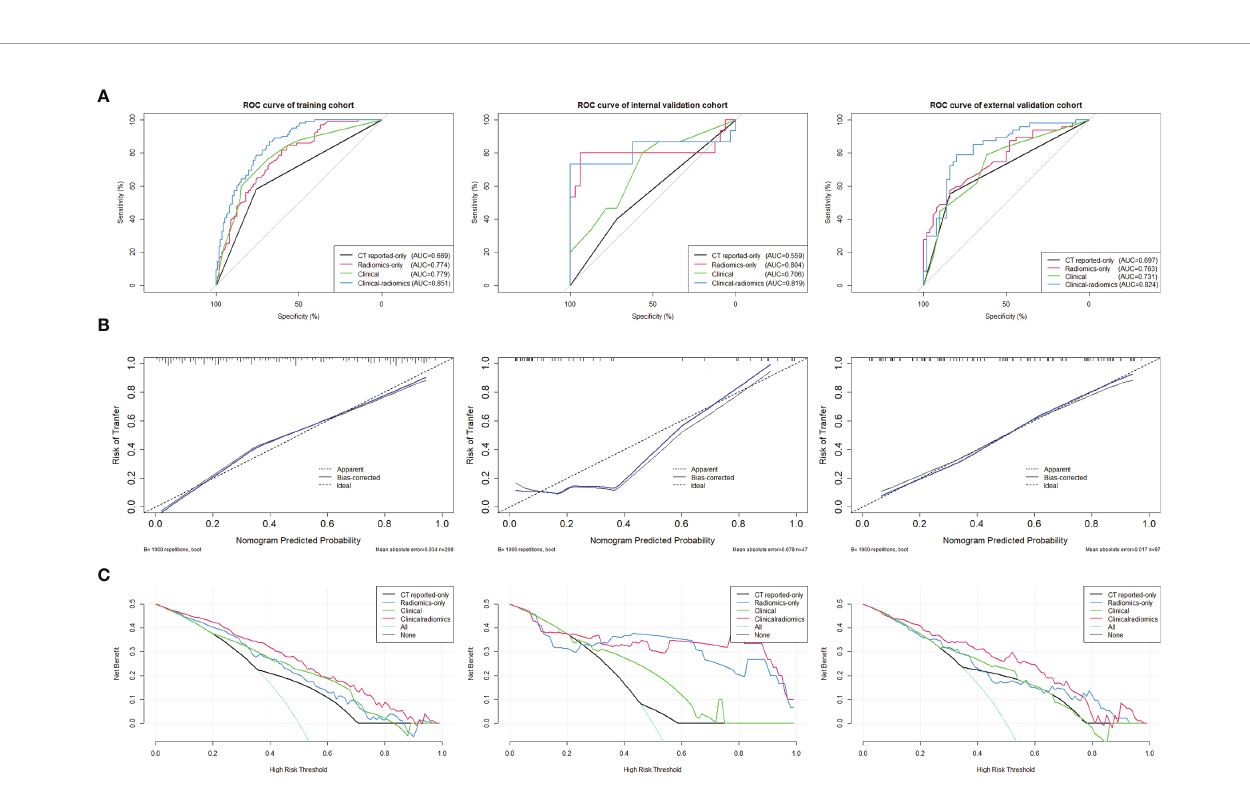
FIGURE 5 | (A) ROC curves ofthe clinical-radiomics model,the clinical model, the Radscore-only model,and the CT reported-only model were shown inthe training cohort, internal validation cohort, and externalvalidation cohort, respectively. (B) Calibration curves of the clinical-radiomics nomogram for predictingLNM between prediction and actualLNstatusin the training cohort, internalvalidation cohort, and external validation cohort. The 45°straight line represents an ideal model perfectly calibrated with an outcome. A closer distance between two curves indicates higher accuracy. (C) Decision curve analysis for the clinical-radiomics nomogram, the clinical model,the Radscore-only model,and the CT reported-onlymodel in both three cohorts. The y -axis measures the net bene fi t. The red line represents the clinical-radiomics nomogram. The blue line represents the Radscore-only model.The green linerepresents the clinical model. The yellow line represents CT reported-only model. The azure line represents the assumption that allpatients hadLNM. The black line represents the assumption that nopatients